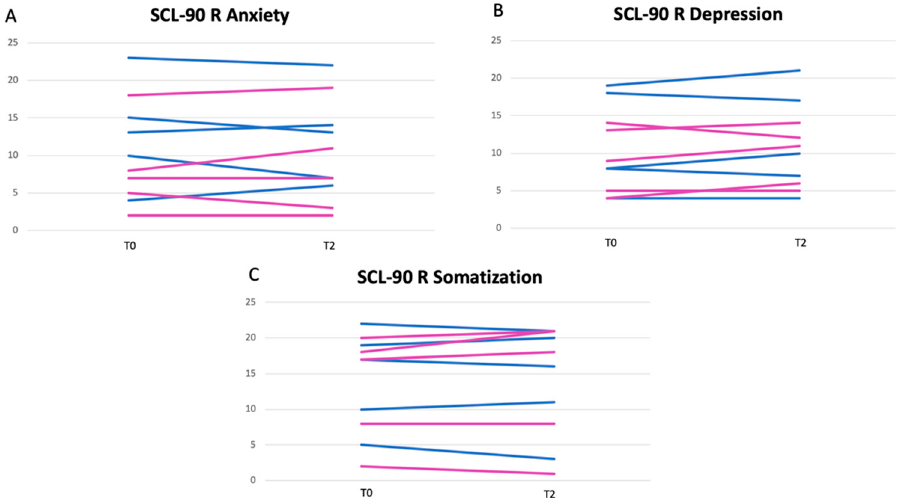
Figure 4. Results of anxiety ( A ), depression ( B ) and somatization ( C ) spheres of SCL-90 question- naires of untreated group. Legend: blue lines for male patients; pink lines for female patients.